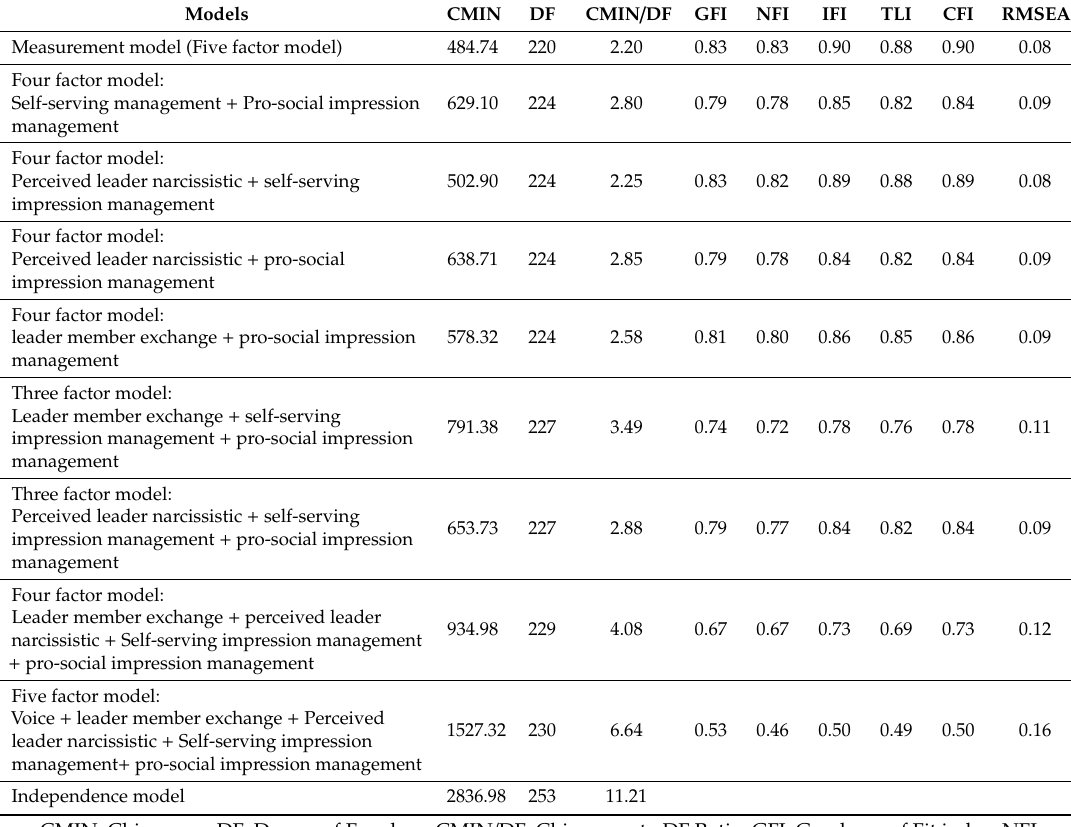
Table 2. Results of measurement model and comparing